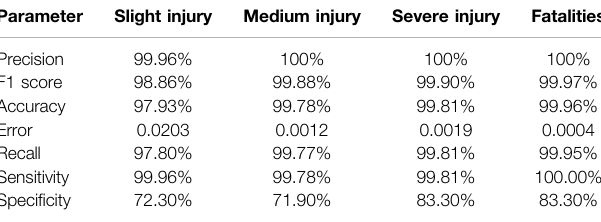
TABLE 2 | Percentages of parameters in the result of random forest.